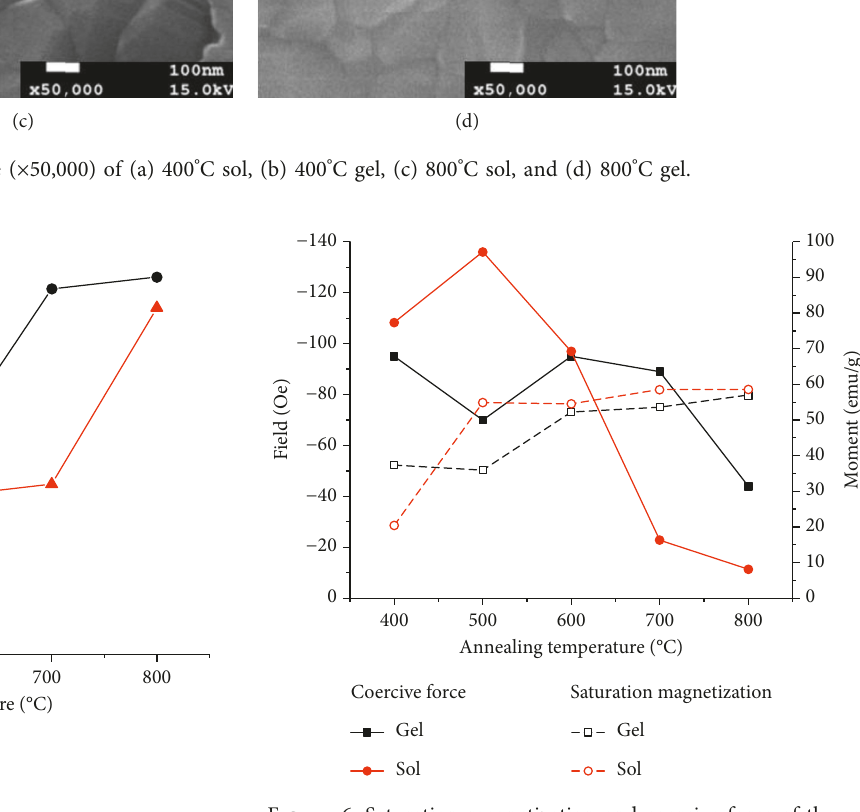
Figure 5: Initial permeability of the sol and the gel with annealing